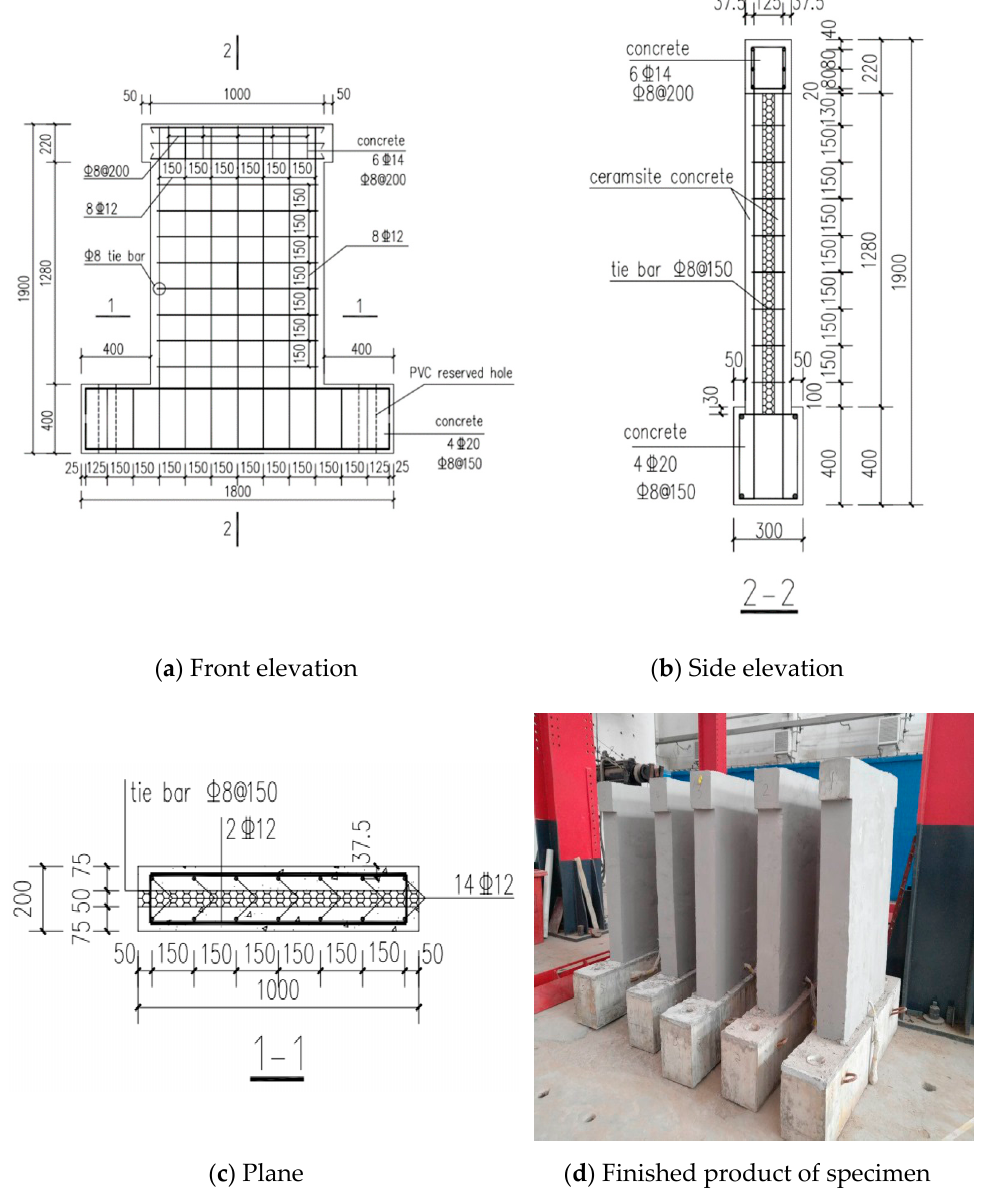
Figure 1. Double-row reinforced ceramsite concrete sandwich composite wallboard. Notes: The unit of length is mm. C8@200 represents HRB335 stirrups with a diameter of 8 mm, and the spacing is 200 mm. C8@150 represents HRB335 stirrups with a diameter of 8 mm, and the spacing is 150 mm. 6C14 indicates six HRB400 rebars with a diameter of 14 mm; 8C12 indicates eight HRB400 rebars with a diameter of 12 mm; 4C20 indicates four HRB400 rebars with a diameter of 20